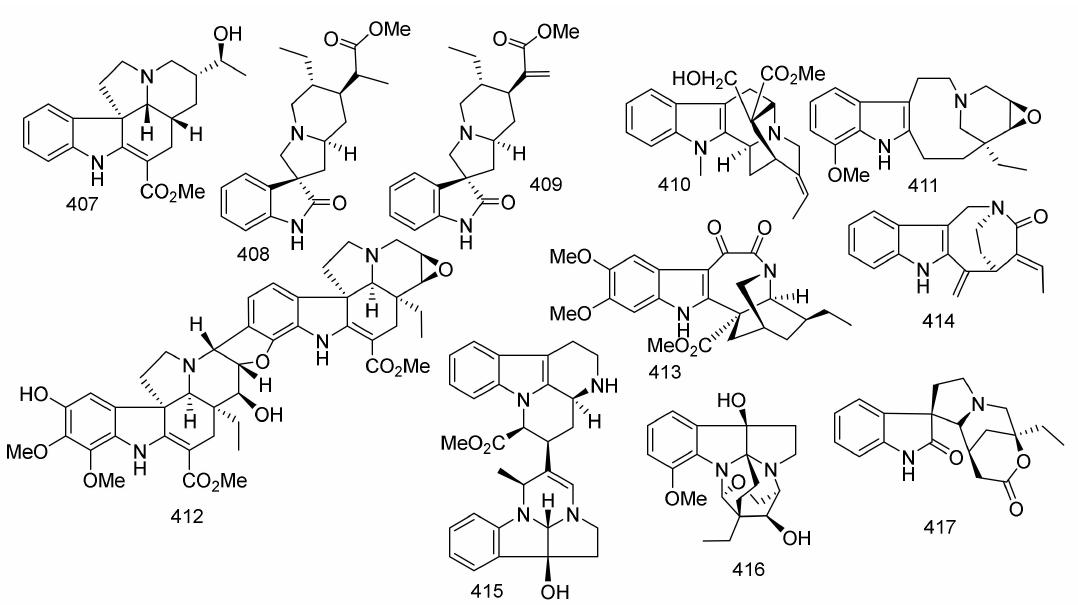
Figure 32. Compounds 407 – 417